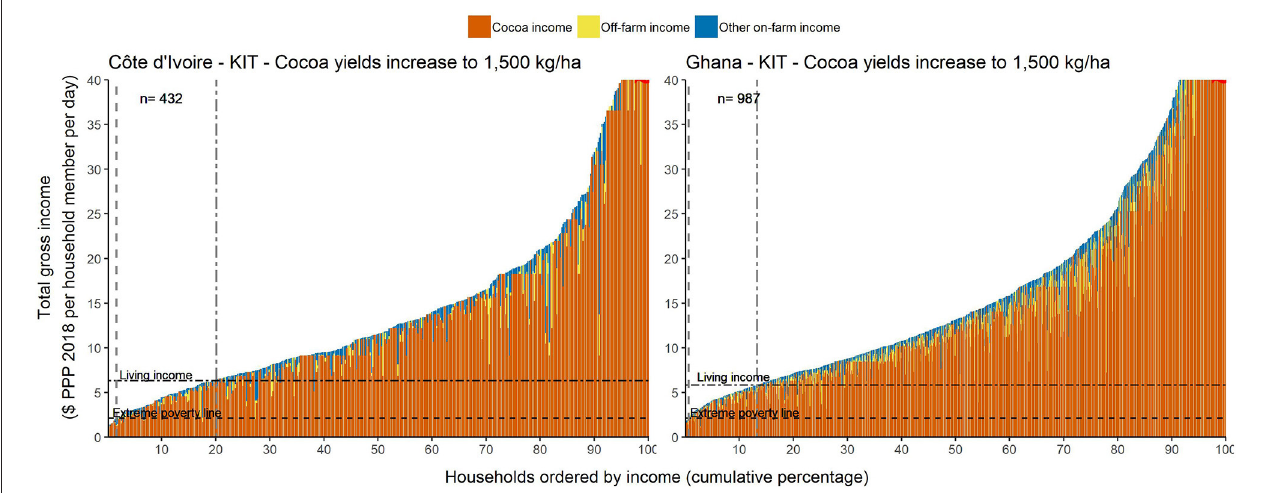
FIGURE 5 | Gross income per household member per day ($ PPP 2018) for each household of the KIT datasets when cocoa yields would increase to 1,500 kg/ha at the cocoa prices of 2015/2016, compared with the World Bank extreme poverty line and the Living Income benchmark based on Smith and Sarpong (2018) for Ghana and CIRES (2018) for Côte